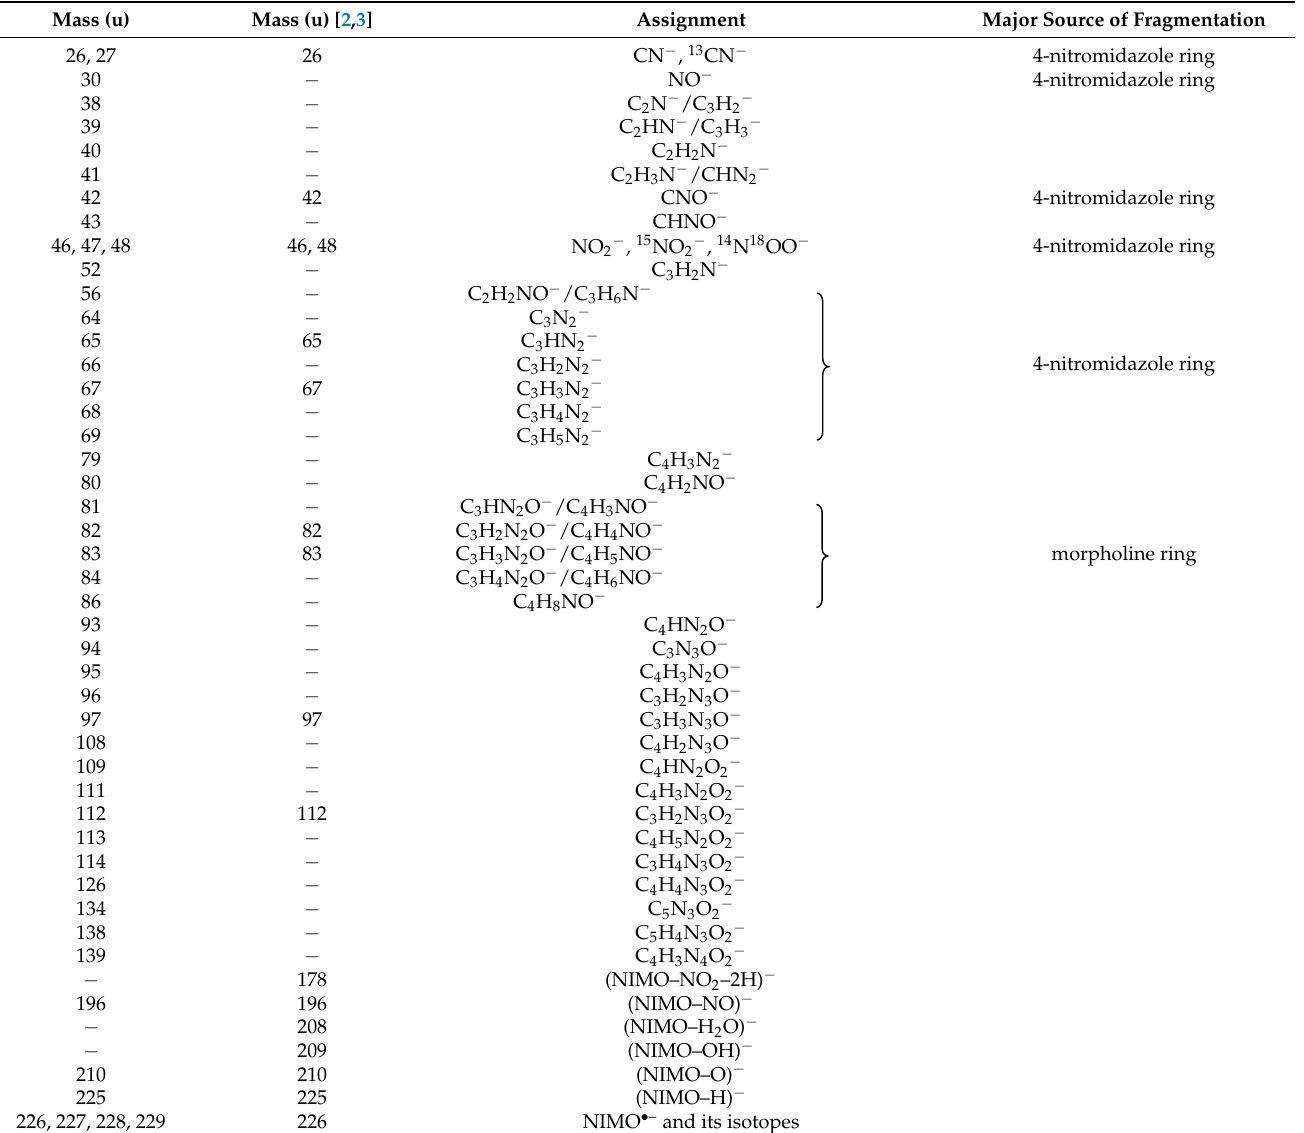
collision-induced decomposition of the 4-nitroimidazole ring, as well as other complex internal reactions within the temporary negative ion formed after electron transfer to neutral NIMO. Yet, these fragment anions are only responsible for less than ~10% of the total ion yield. The branching ratios (BRs) for the most intense anions from NIMO are shown in Figure 3, where a strong energy dependence is discernible. These have been obtained from the integrated time-of-flight mass peak divided by the total anion yield at a given collision energy. This means that, although the non-dissociated parent anion yield in the TOF mass spectra is lower than NO 2 − (Figure 2), its integrated signal comprises 226 u and its isotopes, yielding a branching ratio value that is dominant over all the other fragment anions across the entire collision energy range investigated. Table 1. Proposed assignment of negative ions formed in electron transfer in potassium collisions with nimorazole (NIMO) compared with electron attachment experiments [2,3].